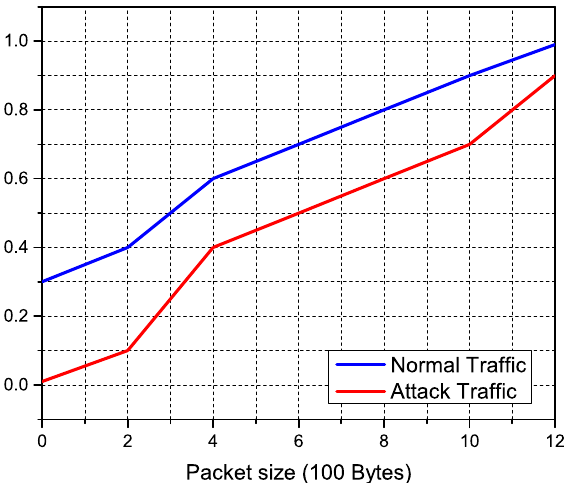
Figure 19. Detecting DDoS anomalies using IoT traffic feature-statistics based on packet sizes.